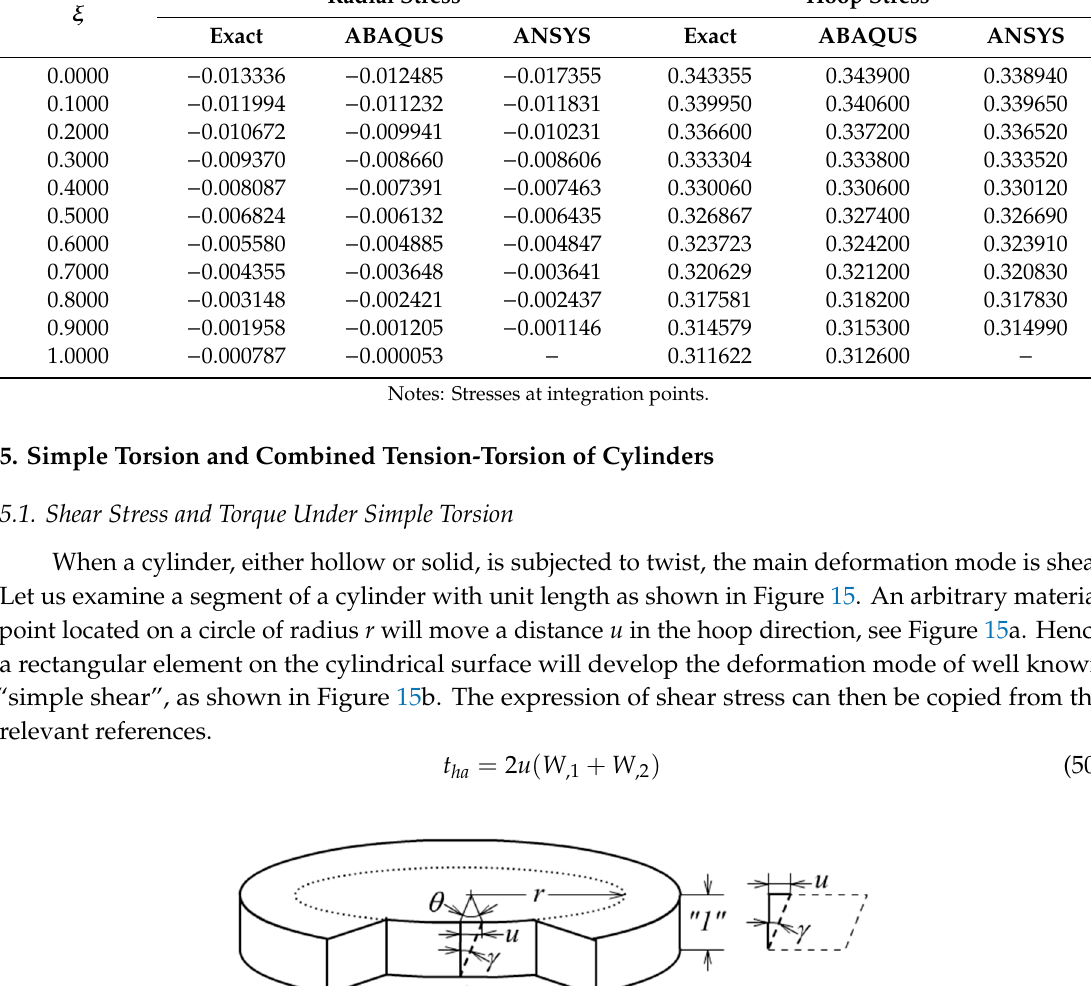
Figure 14. Sketch of the FEM mesh of the balloon.